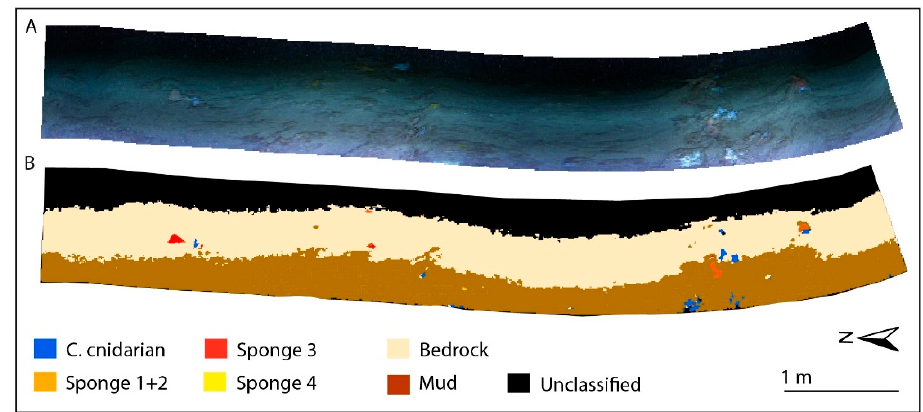
Figure 4. RGB UHI image of the CWC site in A and its SAM classification in B.